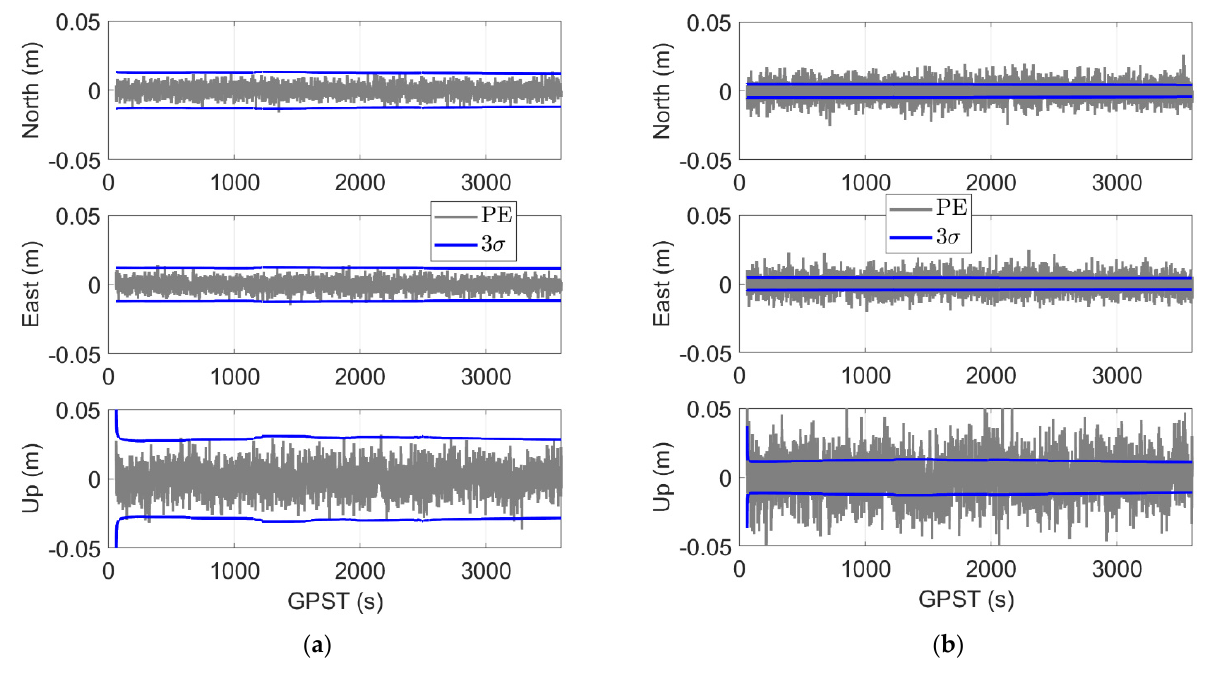
test period. The two panels of Figure 6 distinguish between two cases: